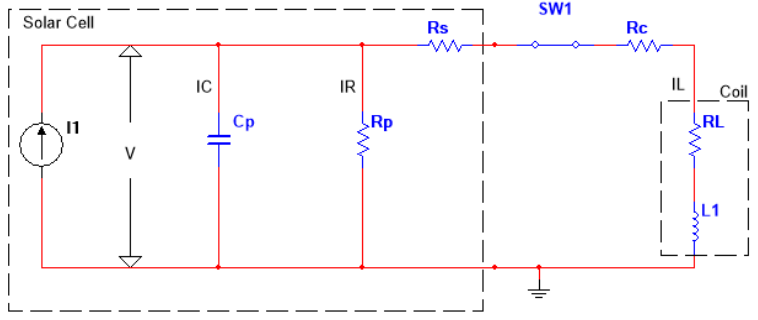
Figure 3. The electrical circuit obtained connecting an inductance coil to a solar cell.